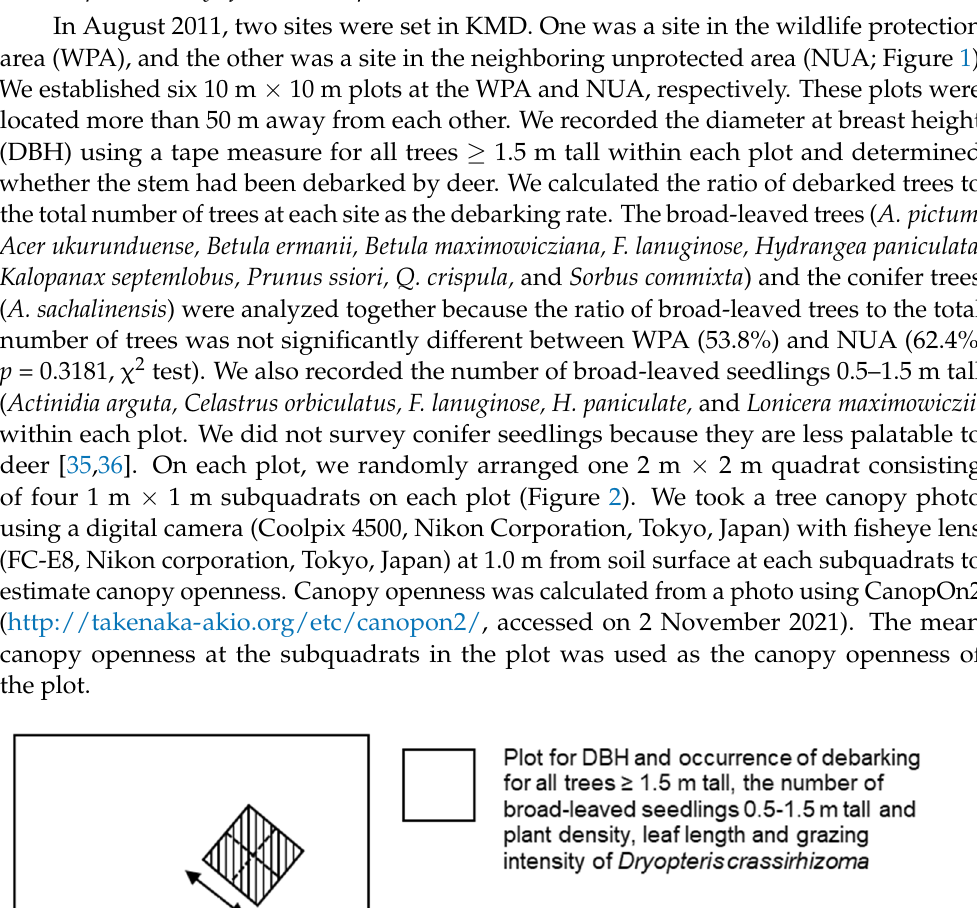
Figure 3. Photographs of Dryopteris crassirhizoma individual of ( a ) ungrazed and ( b ) grazed all- leaves by sika deer. 2.3. Spatial Survey of Indicator Species In August 2014, we randomly set ten sites in KMD, including WPA and NUA, and 11 sites in IMD and established two 10 m × 10 m plots at each site (Figure 1). These plots were located more than 50 m away from each other. We recorded the number of grazed